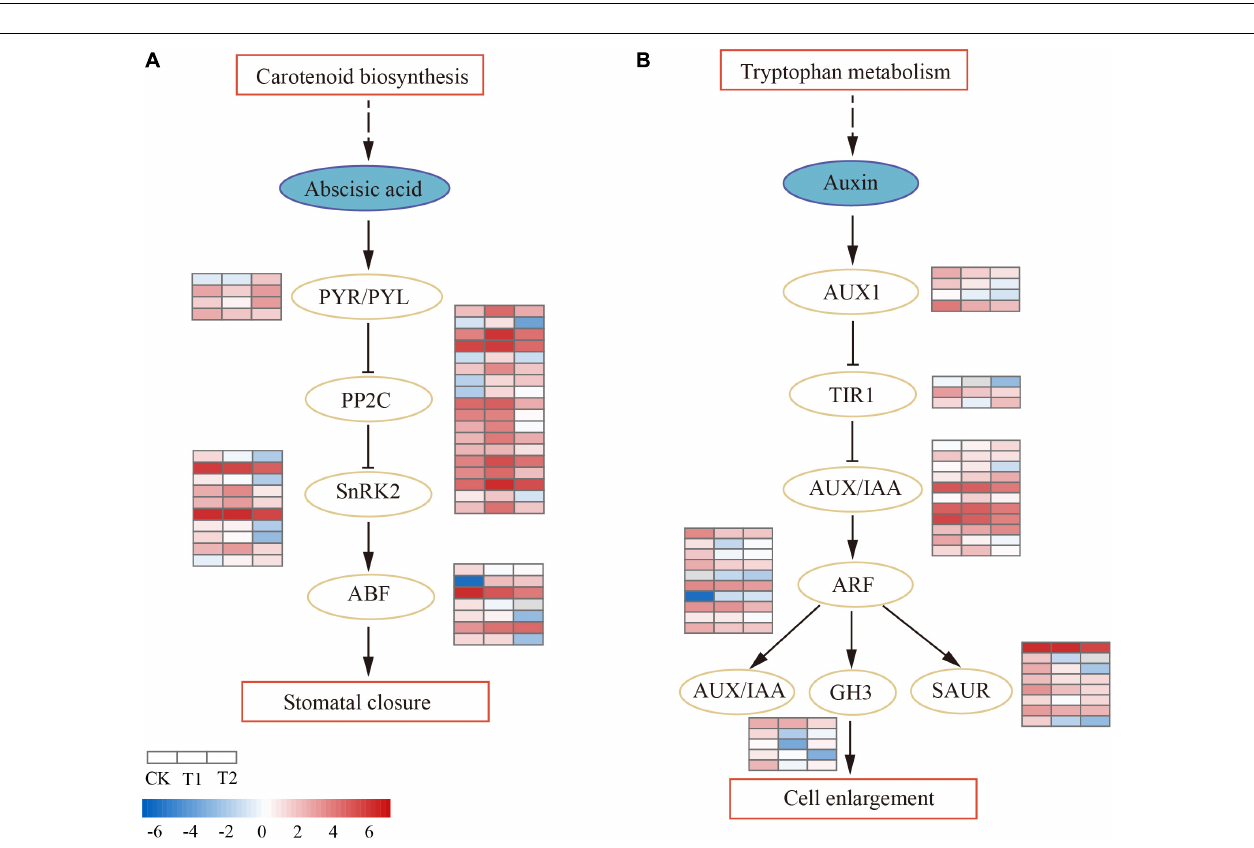
FIGURE 5 | Differential regulation of plant hormone signal transduction pathway in drought treatments. The heatmaps show log 2 FPKM values of the differentially expressed genes (DEGs). (A) Abscisic acid signal transduction pathway. (B) Auxin signal transduction pathway.